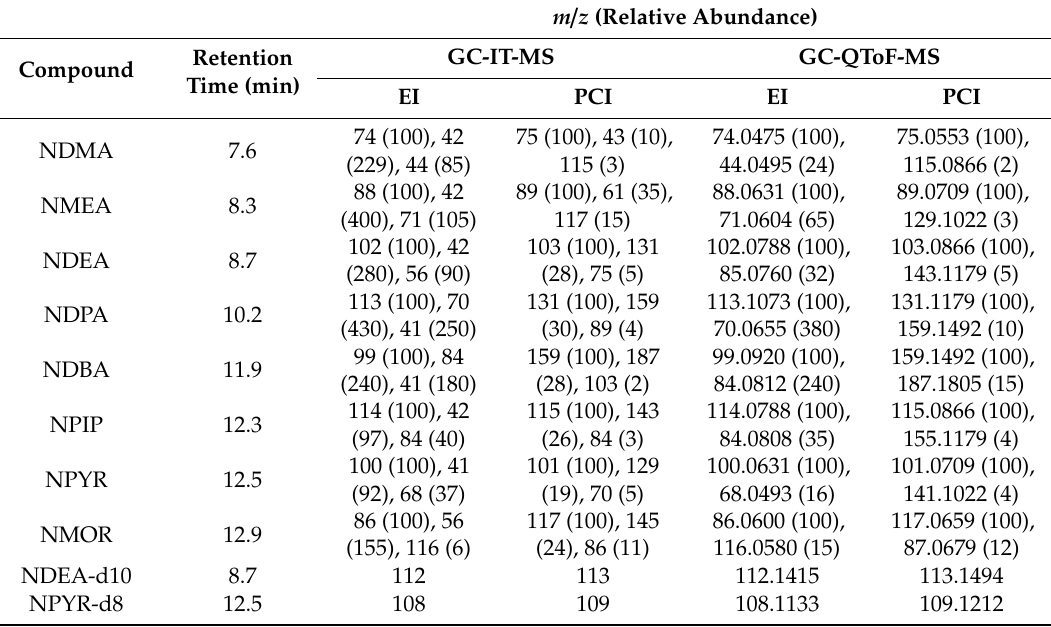
Table 1. Retention time and quantification (first m / z value) and qualifier ions (subsequent m / z values) used in each system. Note: electron impact = EI; positive chemical ionization =